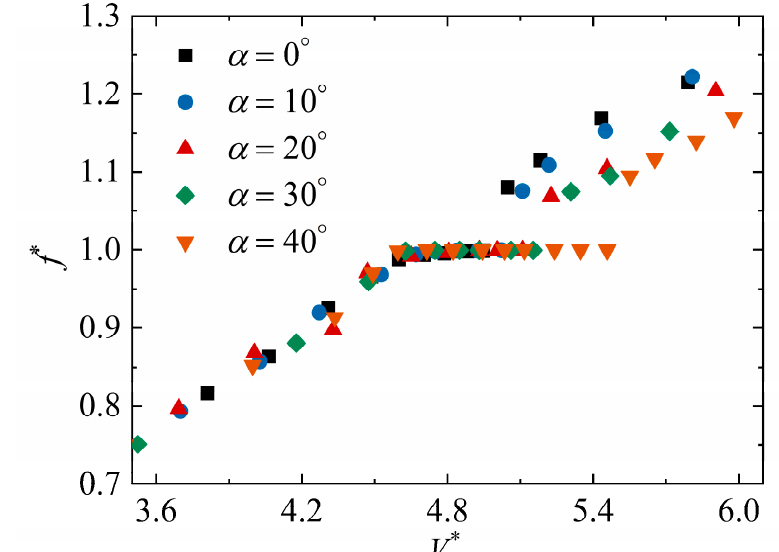
Figure 15. The variation in f * versus V * for different α .